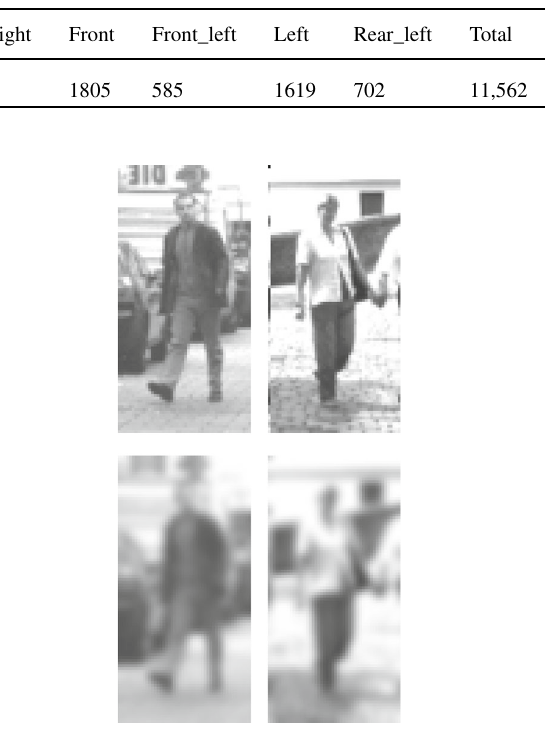
Fig. 11 PDCdatasetimageGaussianblurprocessing,thefirstlineisthe original image, and the second line is the image after Gaussian